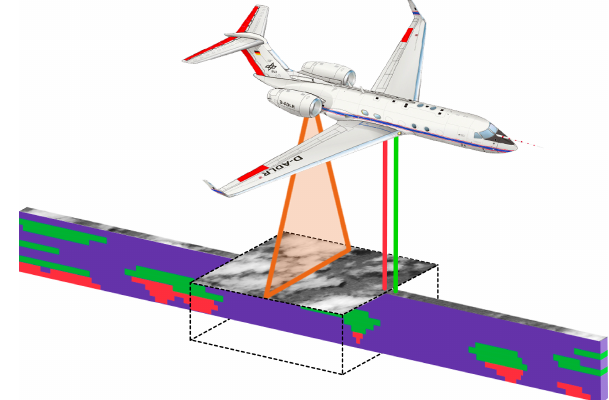
Figure 2. Combined lidar (WALES), radar (HAMP MIRA), and solar radiance measurements (specMACS) from the German High Altitude Long Range Research Aircraft ( HALO ). Lidar (green) and radar (red) provide along-track cross-sections through the atmo- sphere, while the swath of the imager (orange) captures the across- track dimension of the